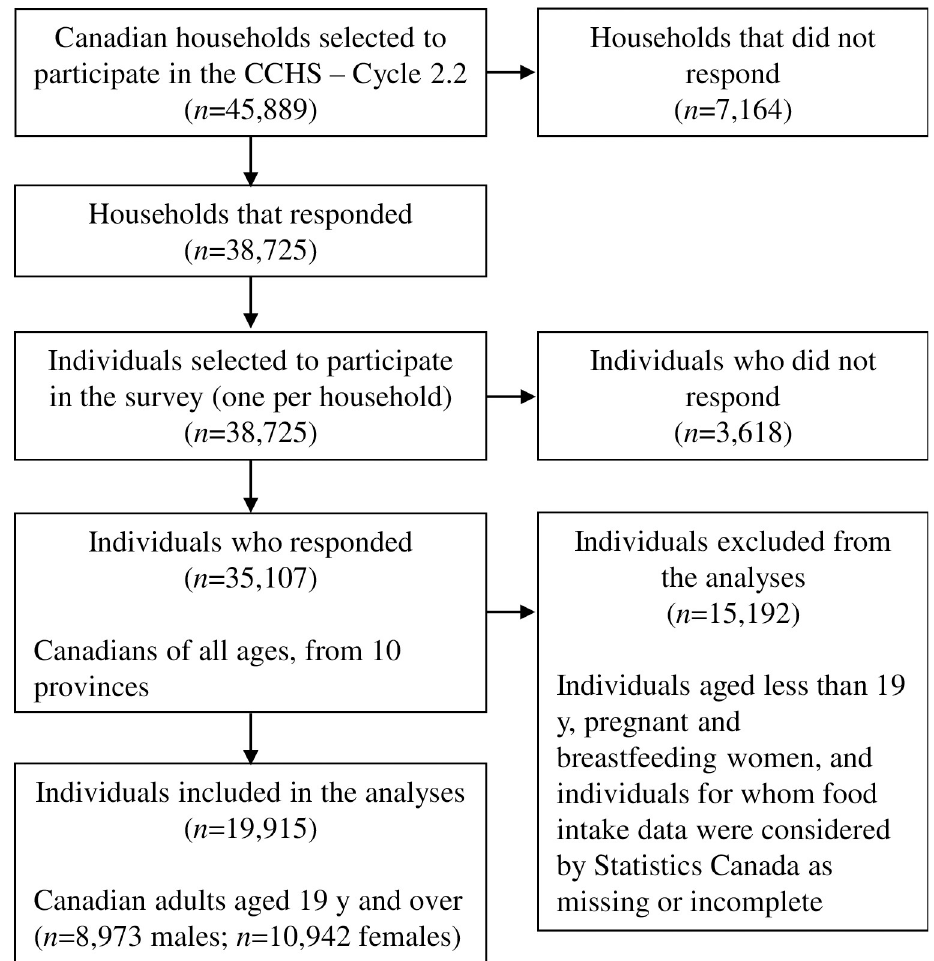
Fig 1. Flow chart of participants in the nationally representative 2004 Canadian Community Health Survey, Cycle